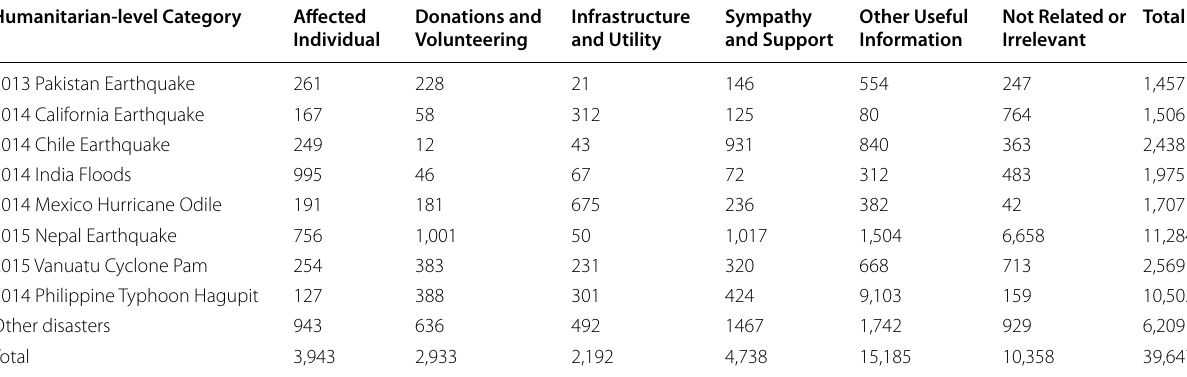
Table 1 Class distribution of annotated disaster events Humanitarian‑level Category Affected Individual